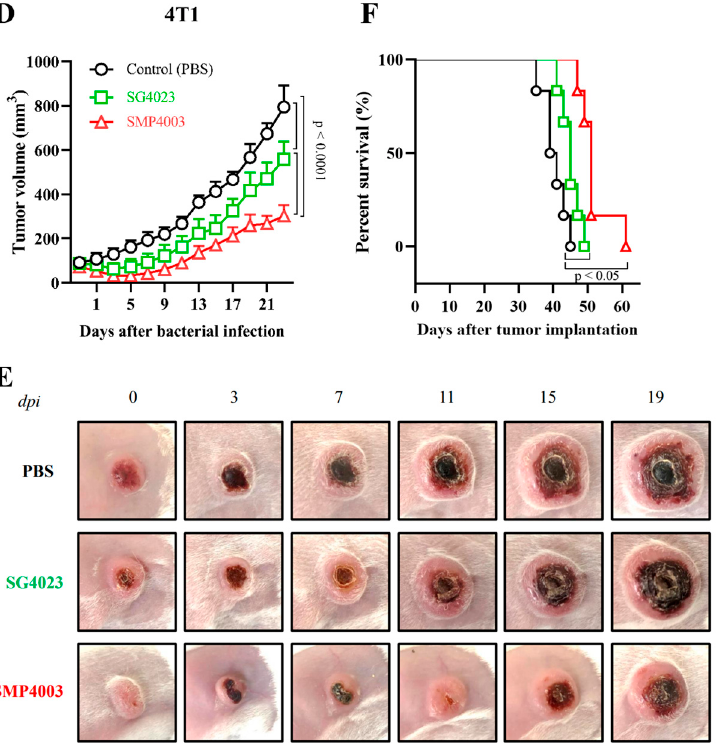
Figure 4. Antitumor effect of ∆ ppGpp S. Gallinarum carrying prrnBP1-psp-TP in BALB/c mice grafted with CT26 colon carcinoma and 4T1 murine breast cancer cells. BALB/c mice were subcu- taneously implanted with 1 × 10 6 CT26 colon carcinoma cells ( n = 5 per group, ( A – C )) or 1 × 10 6 4T1 murine breast carcinoma cells ( n = 6 per group, ( D – F )) on the high flank. Mice were treated with PBS (black line), ∆ ppGpp S. Gallinarum (SG4023, green line), or S. Gallinarum transformed with the therapeutic plasmid prrnBP1-psp-TP (SMP4003, red line) by intravenous injection at a dose of 1 × 10 8 CFU/mouse when tumor volumes reached 90–120 mm 3 . Average tumor sizes in each group of mice grafted with CT26 ( A ) or 4T1 ( D ) were recorded every 2 days after treatment with the engi- neered bacteria until the volumes reached > 1500 mm 3 (two-way ANOVA with Tukey’s multiple comparisons test, p < 0.0001). Representative images of CT26 carcinoma ( B ) or 4T1 carcinoma ( E ) in the above mice. The survival of CT26 tumor-bearing mice ( C ) or 4T1 tumor-bearing mice ( F ) treated